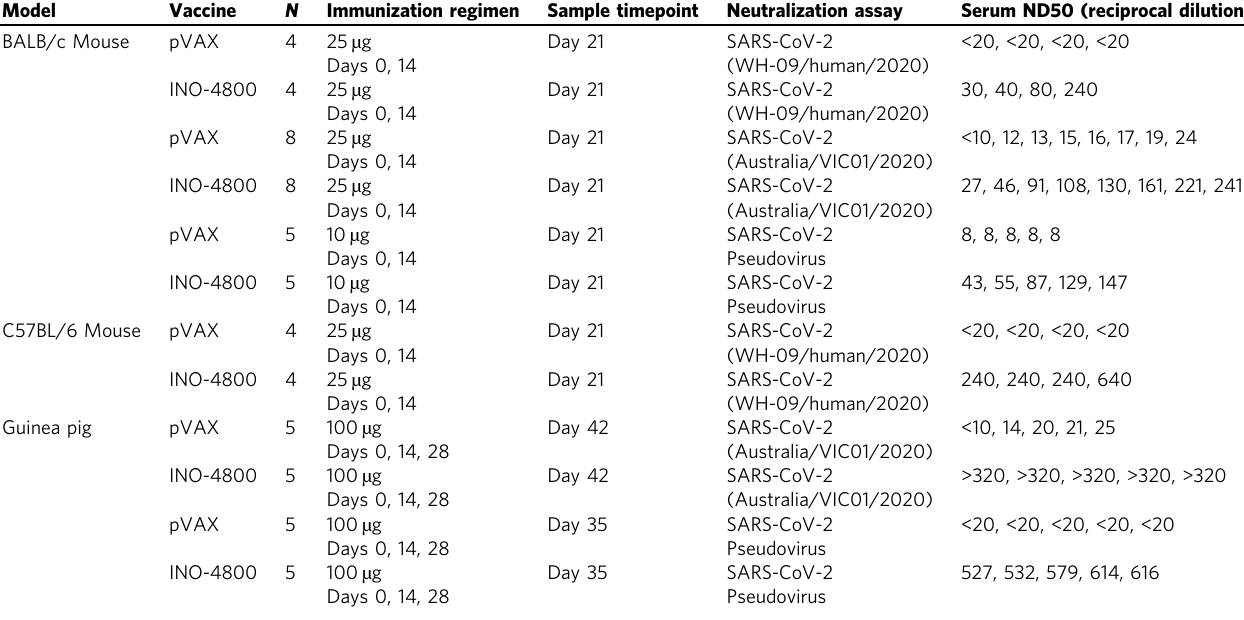
Table 1 Sera neutralizing activity after INO-4800 administration to mice and guinea